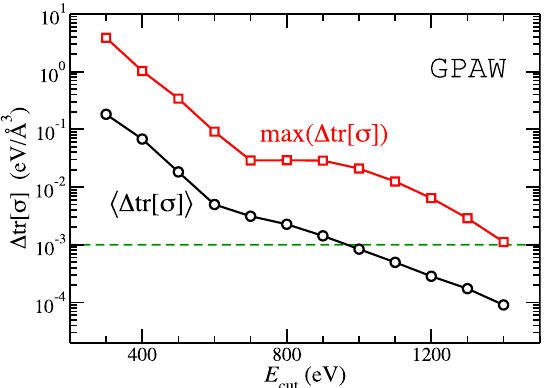
Fig. 5 Average (black circles) and maximum numerical error (red squares) for the trace of the stress tensor σ as function of the cutoff energy E cut . All calculations were performed with GPAW using the PBE functional and an 8 Å k-point density for 71 elemental solids and the experimental lattice constant. The dashed green line highlights the typical error acceptable in high-accuracy lattice